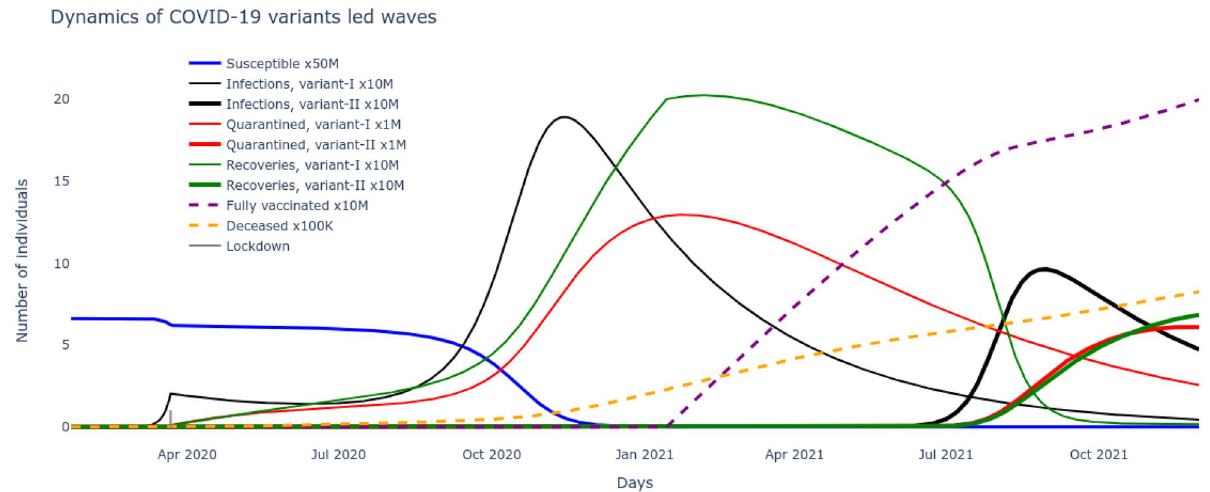
Figure 4. The optimized SI 2 Q 2 R 2 VD system reveals the underlying dynamics of the two major variant-driven waves.